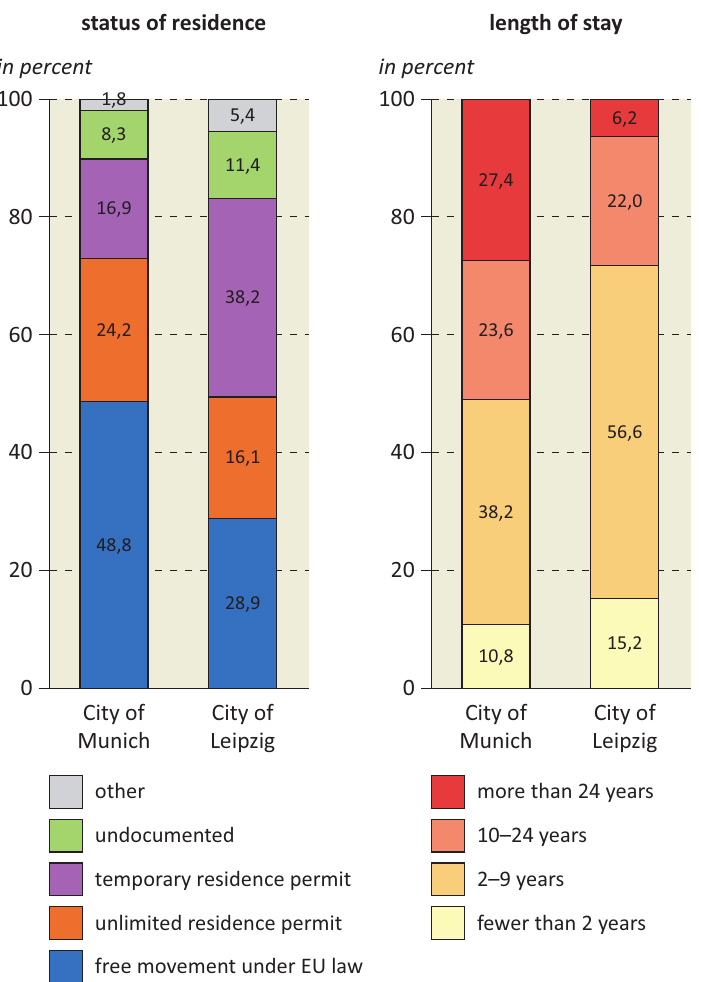
Figure 1. Residence status and length of stay of the foreign population in Munich and Leipzig (%) in 2019. Source: Wiest (2019), based on data from the Federal Statistical Office, Wiesbaden, 2019. also among Munich’s migrant population (Huss,